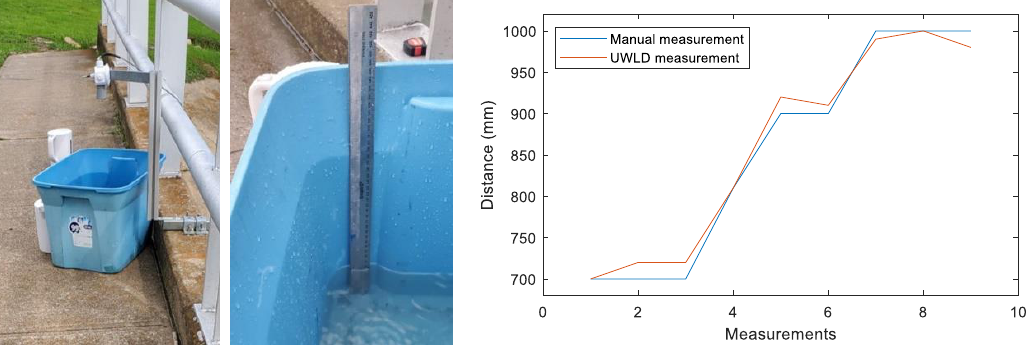
Figure 10. Ultrasonic sensor calibration test ( left ) and measured data ( right ).